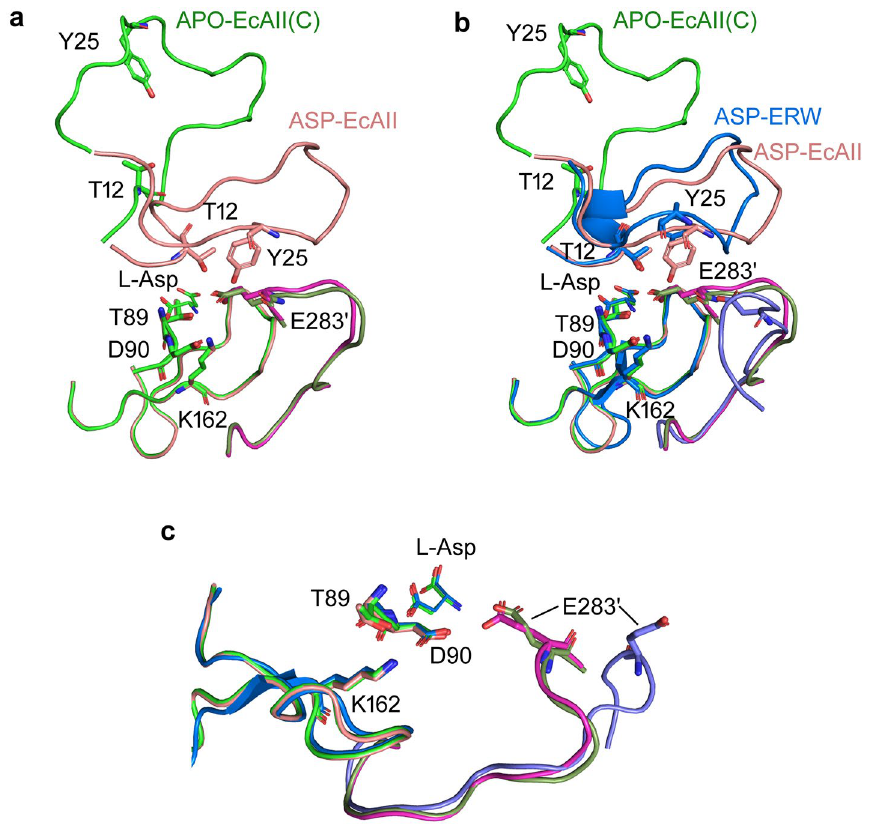
Figure 2. Superposition of APO-EcAII (light or dark green, PDB ID: 6YZI) and EcAII-ASP (light or dark pink, PDB ID: 1NNS) ( a ), and of APO-EcAII (light or dark green, PDB ID: 6YZI) and ErAII-ASP (blue or marine, PDB ID: 5F52) ( b ) catalytic loops. Residues belonging to catalytic triads are represented as sticks. Structural elements belonging to the companion protomer in the intimate dimer are colored in dark for each structure. ( c ) Detail of E283 ′ different localization in